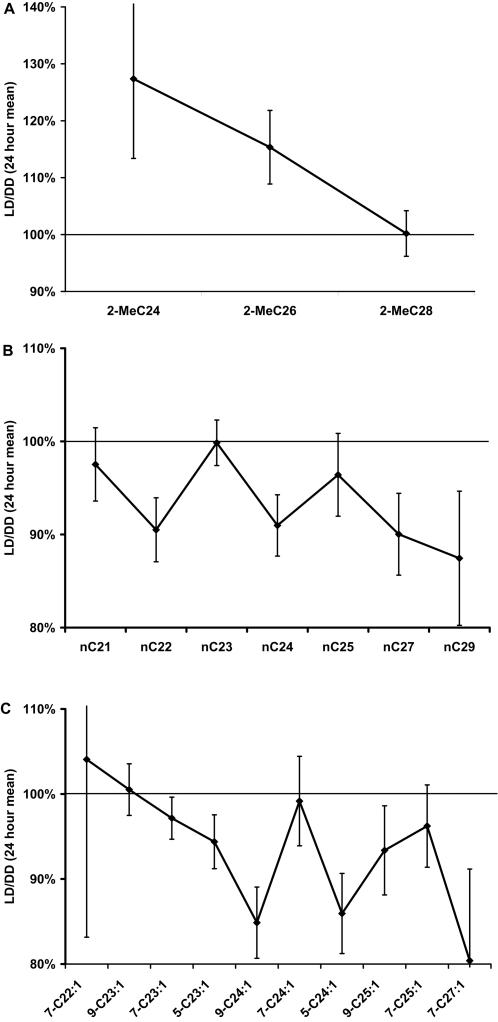
Compound TA-mean abundance ratio, LD/DD.Short chain methyl-alkanes increased in LD, n-alkanes decreased or did not change. Among monoenes, 7-C23∶1 and 9-C25∶1 decreased slightly but significantly in LD (p<0.003), while 5-C23∶1,9-C24∶1,5-C24∶1, and 7-C27∶1 decreased more (p<5e-6). Error bars show 99% confidence intervals. Averages of 24 hours of data were compared for the two treatments.